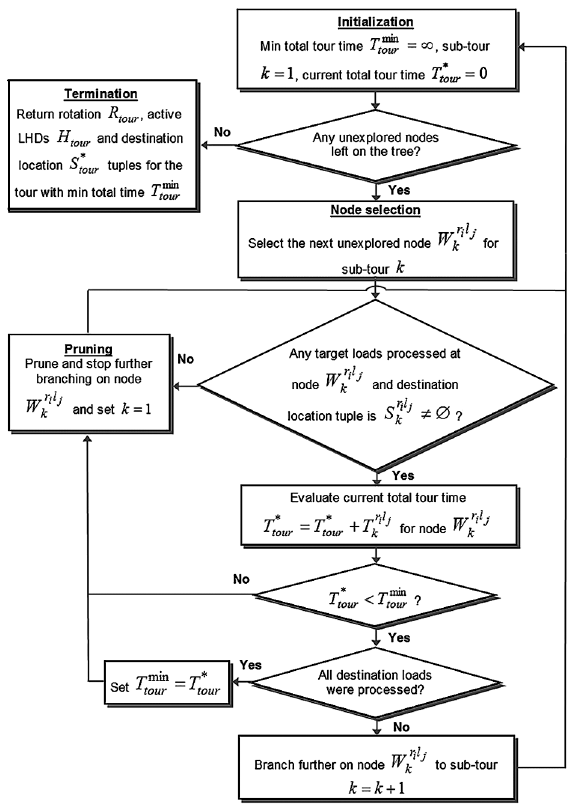
Fig. 6. Optimal routing